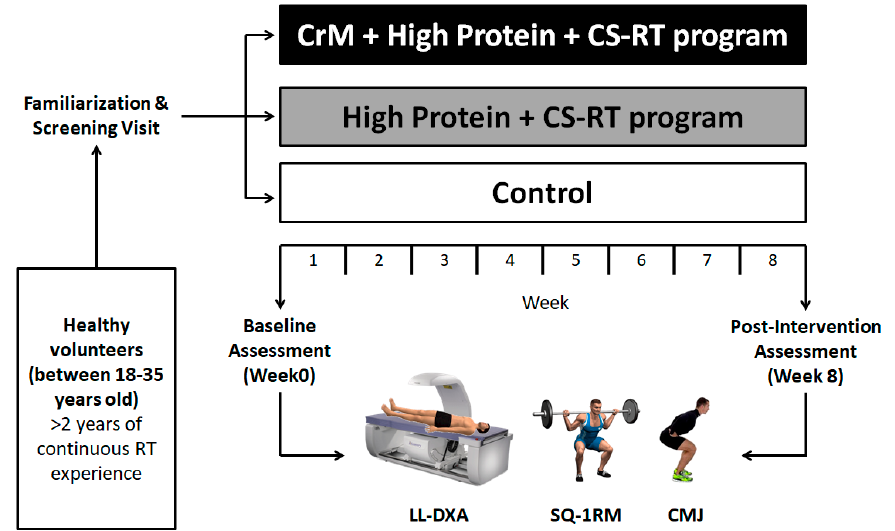
Figure 1. Experimental design of the study. CMJ: countermovement jump; CrM: creatine monohy- drate; CS-RT: cluster-set resistance training; LL-DXA: lower-limb assessment with dual-energy X-ray absorptiometry; SQ-1RM: 1 repetition maximum for the back squat.